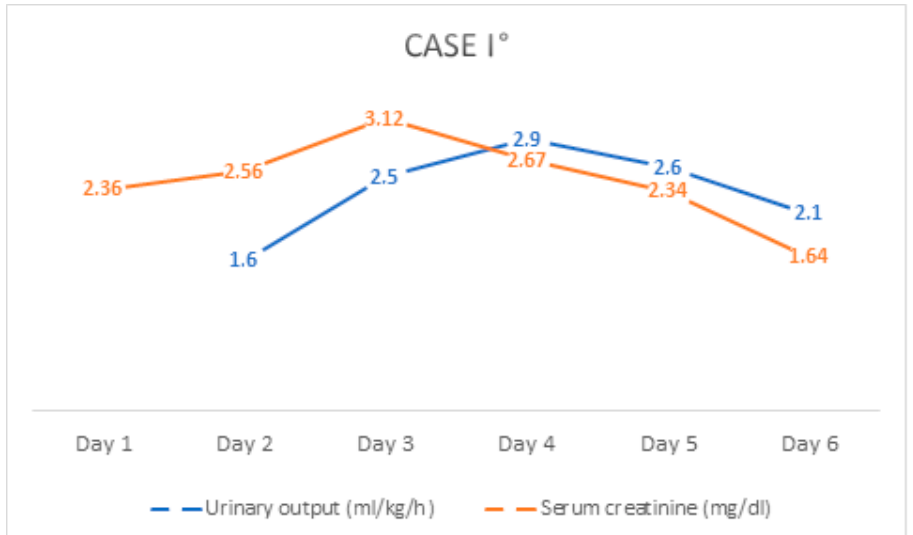
Figure 3. The course of serum creatinine value and urinary output of Case I° during hospitalization .